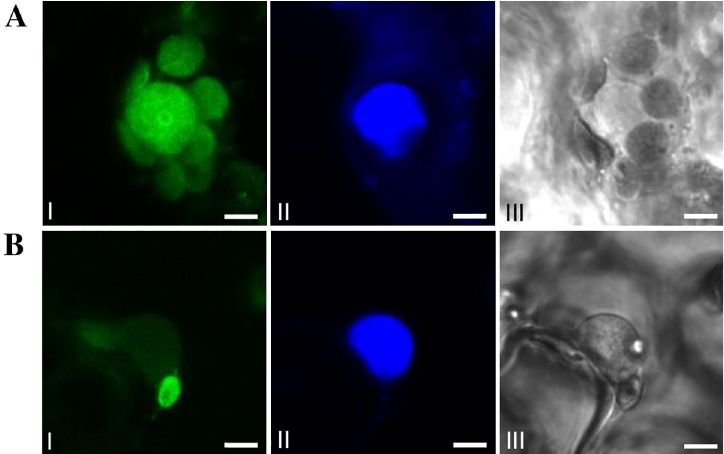
Fig 3. Subcellular localization of ScMYBAS1 proteins. The fusion constructs for ScMYBAS1-3:GFP (A) and ScMYBAS1-2:GFP (B) were introduced into Nicotiana benthamiana leaves via Agrobacterium infiltration . In (A) and (B) it is possible to verify a nuclear localization. Subcellular localization was investigated by confocal microscopy: I— GFP fluorescence; II—nucleus labeled with DAPI fluorescence; III—bright field image. Bars = 12.5 μ m.